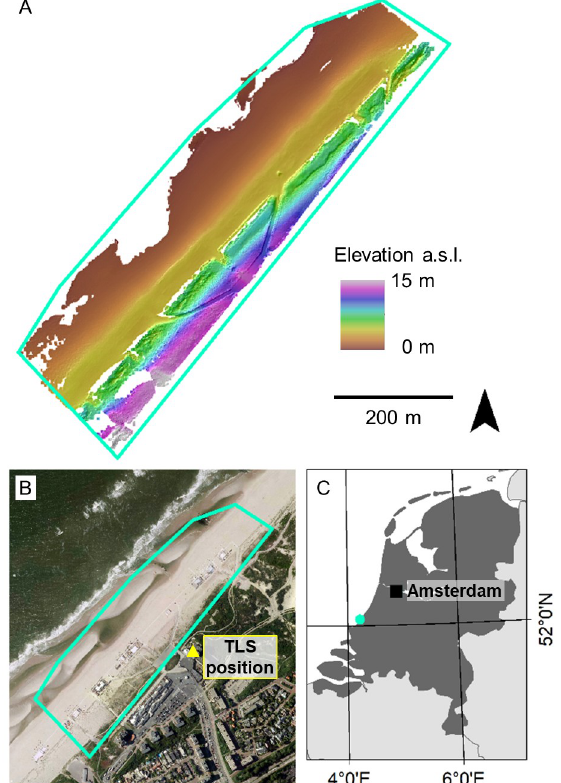
Figure 2. (A) Terrain elevation of the study site (based on TLS data) with extent designated in (B) aerial imagery of the beach at Kijkduin. (C) Overview map with location of the study site in the Netherlands. Data: Aerial imagery © pdok.nl 2017, World Borders © thematicmapping.org 2017